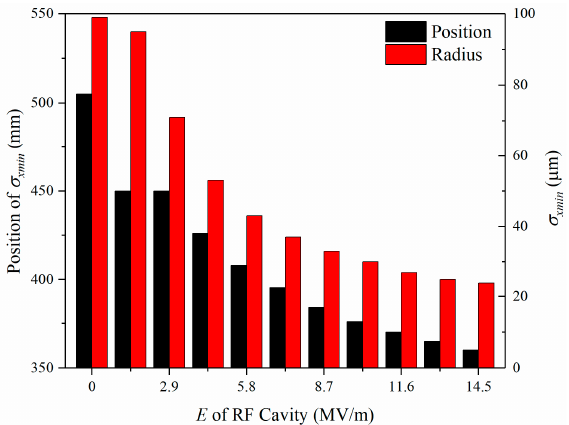
Figure 7. Focus radius σ xmin and its position evolve with the gradient change of the strength of the RF cavity.